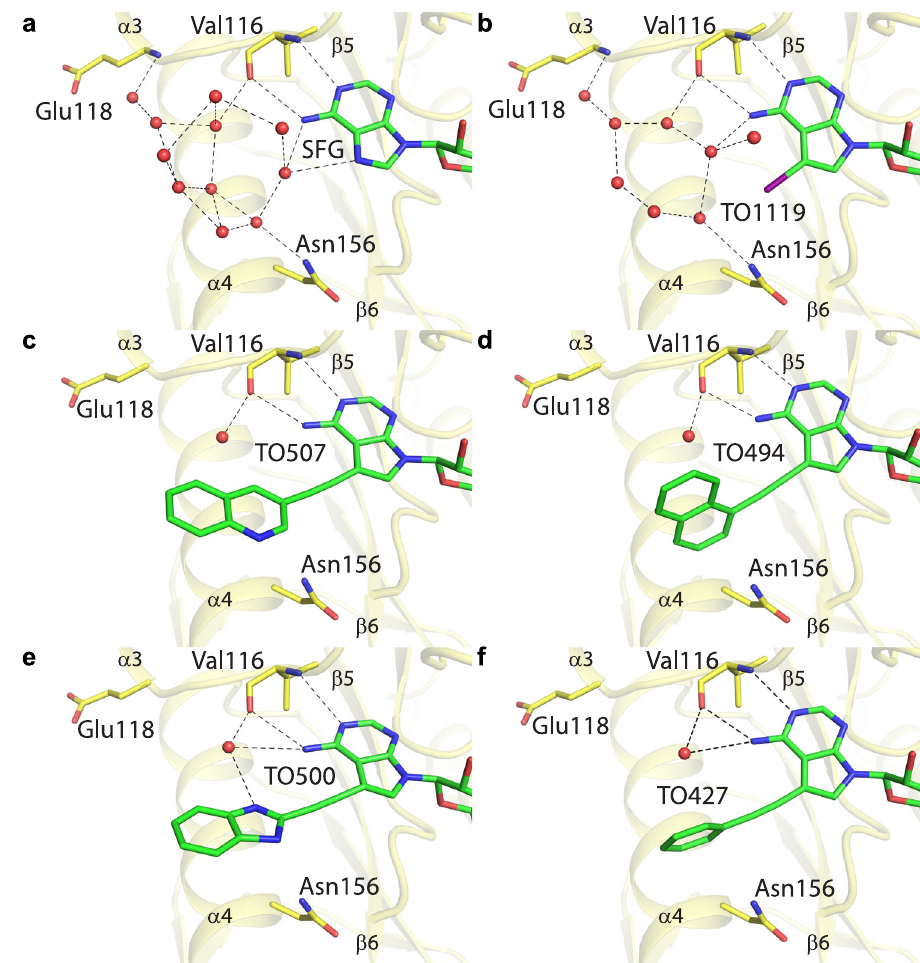
Fig. 3 | A network of coordinated water molecules in the vicinity of the sine- fungin binding groove is disturbed by inhibitor binding. a Detailed view of the water molecules coordinated next to the adenine base of sinefungin. Sinefungin and the side chains of selected VP39 amino acid residues are shown in the stick